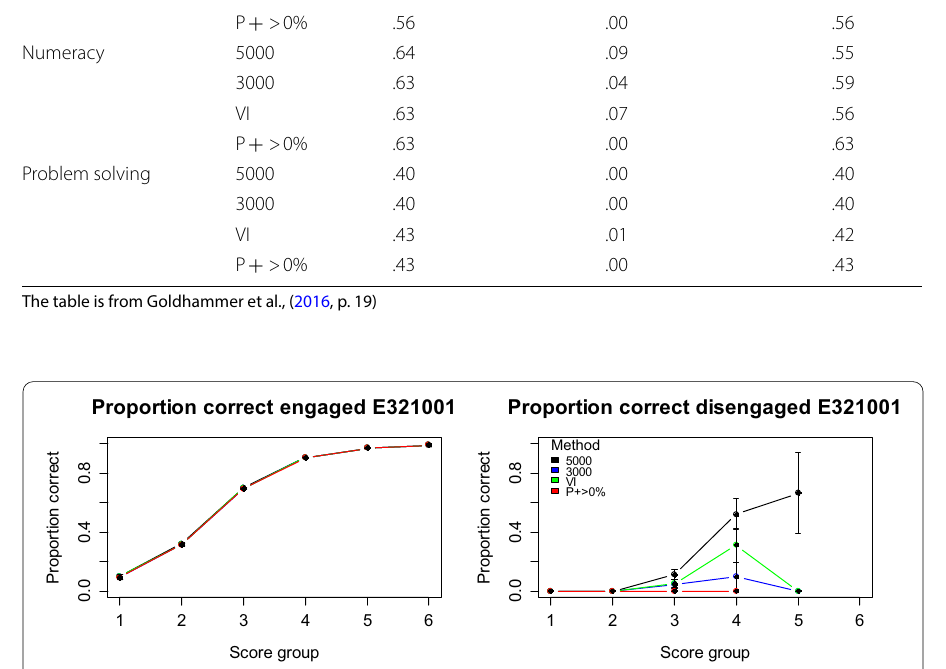
Fig. 4 Relationship between score group and proportion correct for literacy (selected item) (figure from Goldhammer et al., 2016, p.